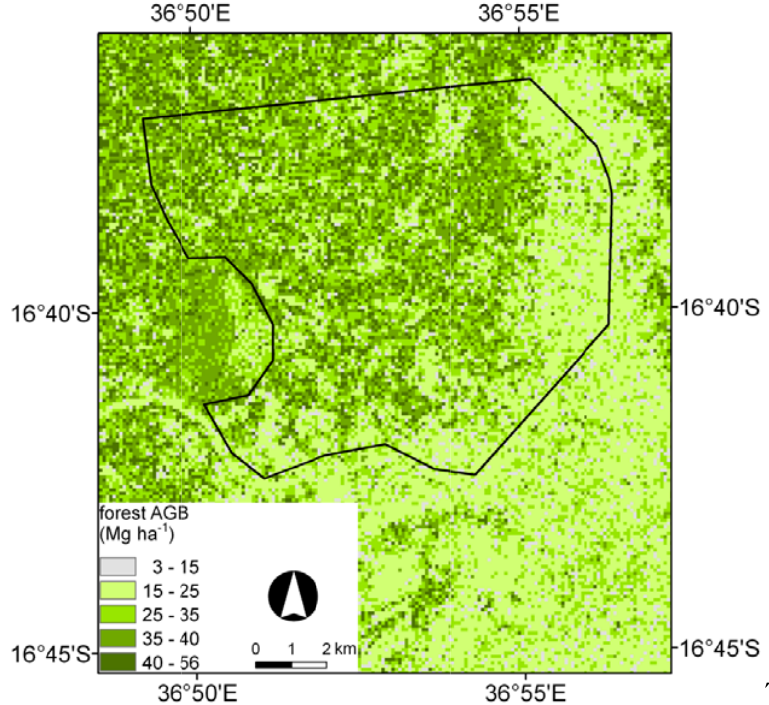
applic the leg used. I 5 Mg·h